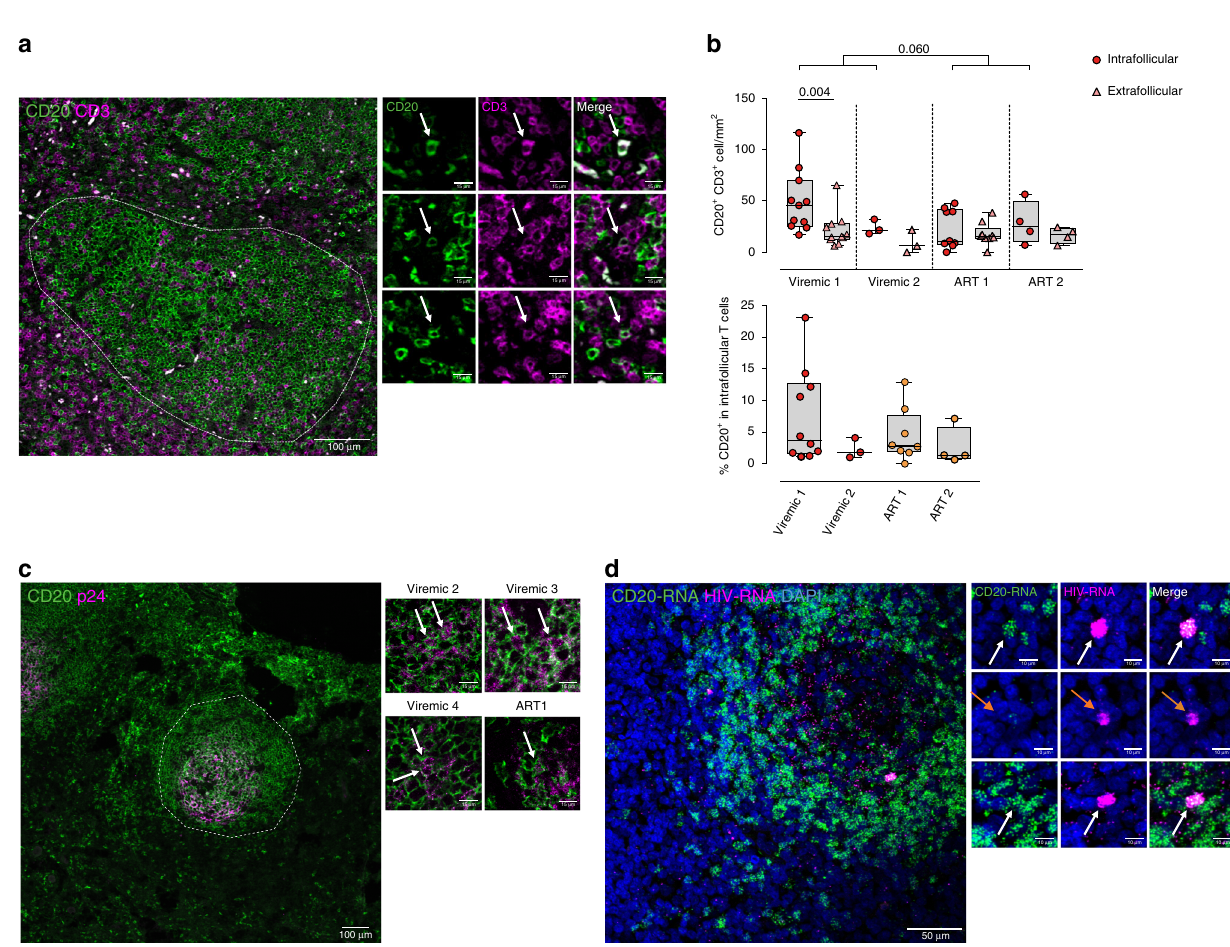
Fig. 4 CD20 expression in T cells of intact human lymph nodes. Paraf fi n-embedded lymph node sections from HIV-infected patients were stained with anti-CD20 combined with anti-CD3 ( a ) or anti-p24 antibodies ( b ), alternatively sections were proceed for in situ RNA-hybridization of CD20-mRNA or mRNA and HIV RNA ( c ). a Representative micrograph of a lymph node section from one viremic HIV + patient stained with anti-CD20 (green) and anti- CD3 (violet) antibodies. The discontinuous line indicates a B-cell follicle and the white arrows double positive cells. Right panels correspond to zoomed views from different patients. b Upper panel shows the number of cells per mm 2 expressing CD20 + and CD3 + in lymph nodes (circles, each dot corresponds to one follicle) and in the extrafollicular region (triangles, each dot corresponds to one optical fi eld). Two HIV-viremic (#84 and 85, in red) and two ART-suppressed patients (#31 and 32, in orange) are shown. Comparison between values inside B-cell follicles from viremic and ART-suppressed patients was performed using a Mann – Whitney test, and comparison within viremic 1 was performed with the Wilcoxon test. Lower panel shows the percentage of CD3 + cells within the B-cell follicle expressing CD20. Each dot corresponds to one follicle. Medians and min – max rank are represented. c Representative micrograph from a lymph node section from one HIV-viremic patient stained with anti-CD20 (green) and anti-p24 (violet) antibodies. High magni fi cation images correspond to B-cell regions from different ART-suppressed and viremic patients, white arrows indicate double positive cells and the discontinuous line indicates B-cell follicle. Patients #31 and 82 – 84 are shown. d Representative image of a B-cell follicle section from one viremic patient (#82) subjected to the in situ hybridization technique. CD20-mRNA is represented in green and HIV RNA in violet. At the middle, zoomed images of double positive cells (white arrows) or HIV RNA single positive cells (orange arrows). Data underlying this Figure are provided as Source Data fi